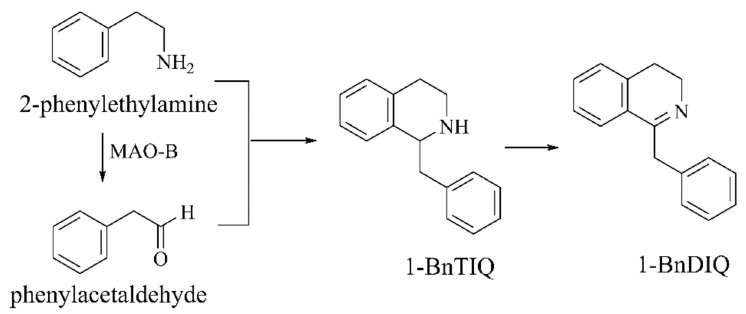
Figure 7. The biosynthesis and metabolism of 1-BnTIQ [62,65].